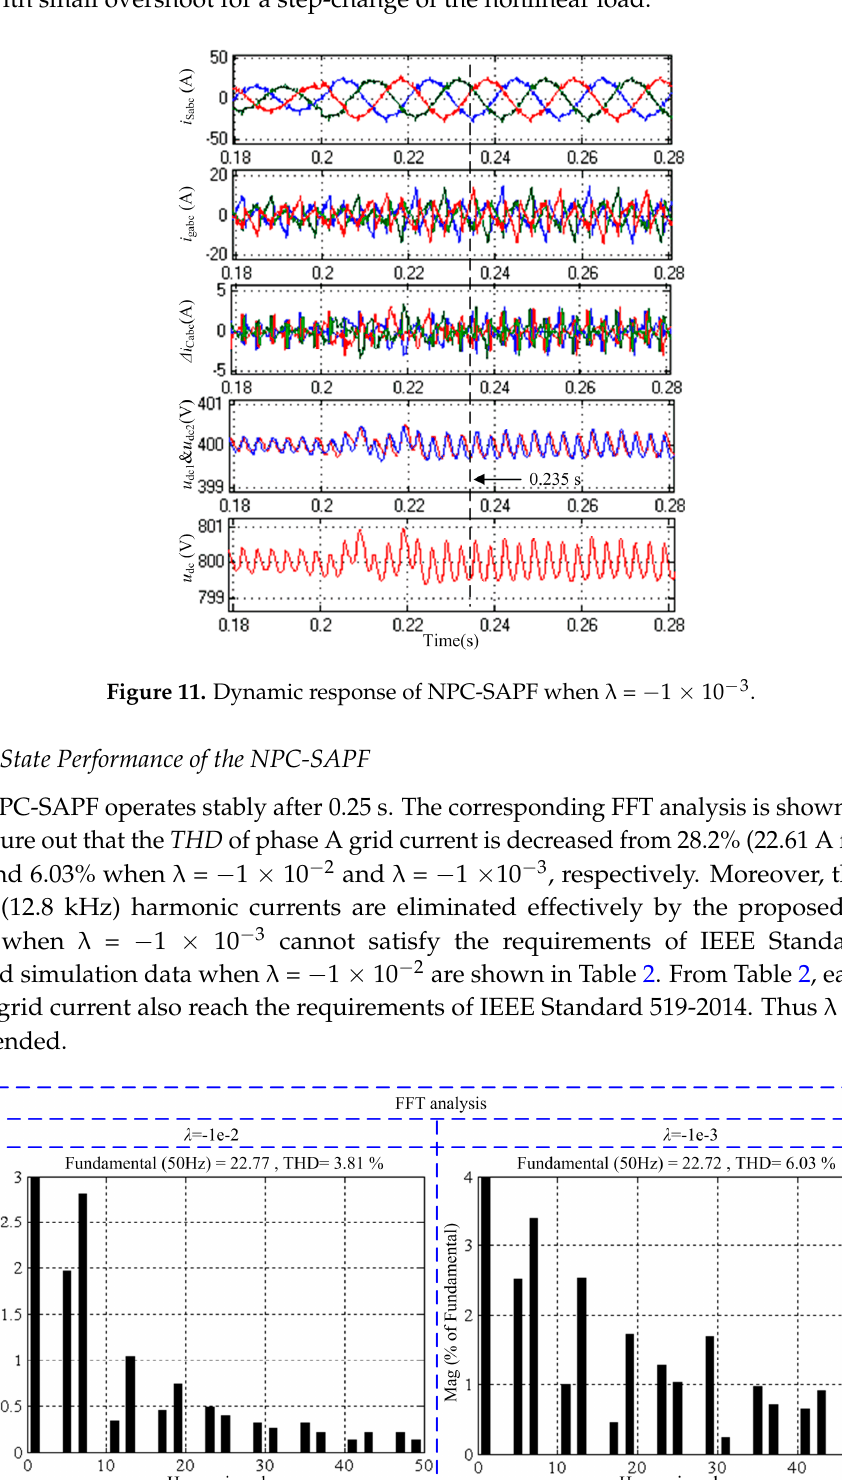
Figure 10. Dynamic response of NPC-SAPF when λ = − 1 × 10 − 2 .